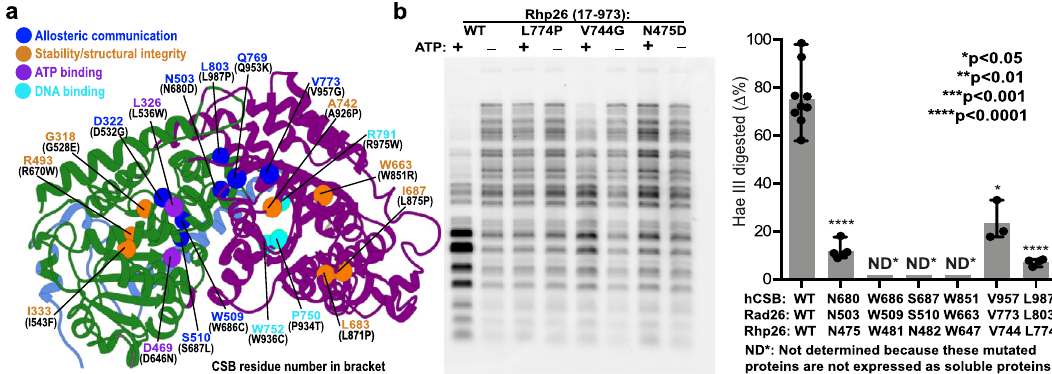
Fig. 6 Cockayne syndrome disease mutations occupy distinct positions in the Rad26 dynamic network. a Cockayne syndrome missense disease mutations (sphere) mapped onto Rad26 and classi fi ed by type of structural or dynamic disruption they induce. Mutations are shown as disrupting allosteric communication/dynamic coupling (blue), the structural integrity or residue packing within the ATPase domains cores (orange); ATP binding (purple); DNA binding (cyan). The yeast Rad26 residues are labeled in blue while the residue numbering in human CSB sequence is shown in black in parentheses. Rad26 dynamic communities are colored in green, purple, and light blue. b In vitro DNA translocase activities of S. pombe CSB ortholog Rph26 mutated proteins measured by a chromatin remodeling assay. The Rhp26 remodeling activity is characterized by analyzing the pattern changes of the restriction enzyme HaeIII cleavage in nucleosomes assembled on a 3 kbp plasmid DNA. The three mutations at positions corresponding to CS disease mutants in the human CSB sequence dramatically reduce chromatin remodeling activity. Quantitation of enzyme activities are shown in the right panel. The experiments were repeated at least three times independently with similar results. Mean values and standard deviations are shown as column bars. p -values were calculated using Two-tailed Student ’ s t test ( p -values N475D/4.89E − 08, V744G/0.0297 and L774P/5.46E − 07, respectively). Source data are provided as a Source Data fi